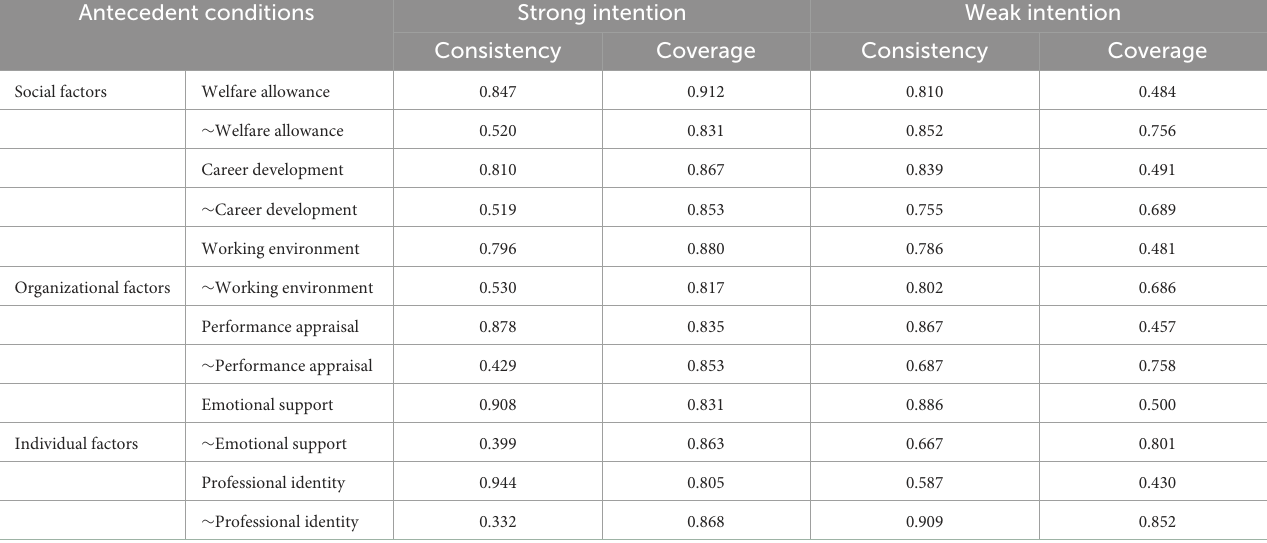
TABLE 5 Necessary conditions analysis of factors influencing the intention to stay in education.